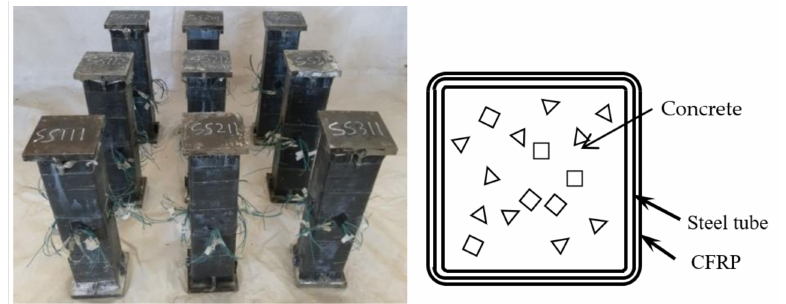
Figure 1. Diagram of S-CF-CFRP-ST and members before